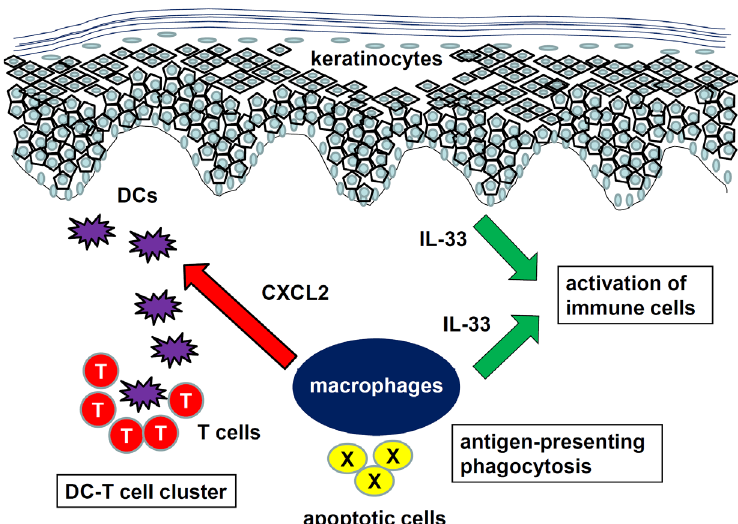
Figure 1. Role of macrophages in AD and CHS. Macrophages mediate antigen-presenting phagocytosis, production of inflammatory cytokines such as IL-33, and cluster formation between DCs and T